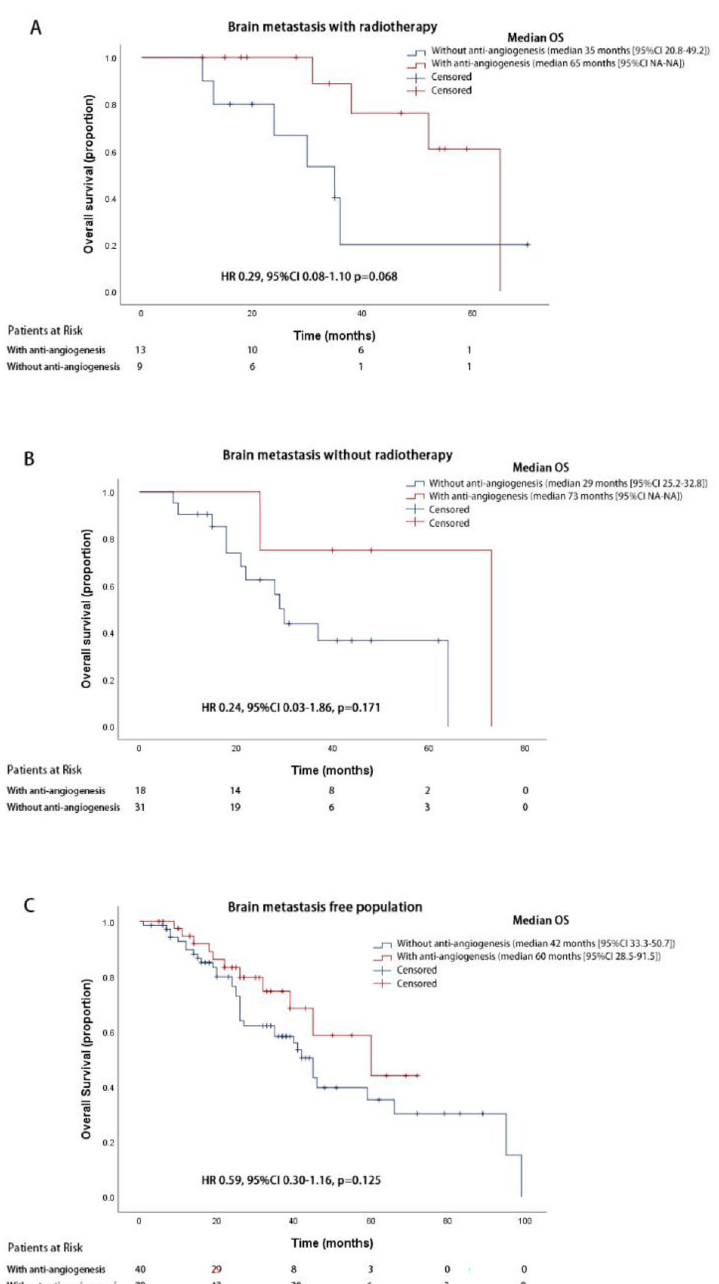
Figure 4. Kaplan–Meier survival curve of overall survival for brain metastatic patients with brain radiotherapy ( A ), brain metastatic patients without brain radiotherapy ( B ), brain metastasis-free patients ( C ) treated with or without anti-angiogenesis